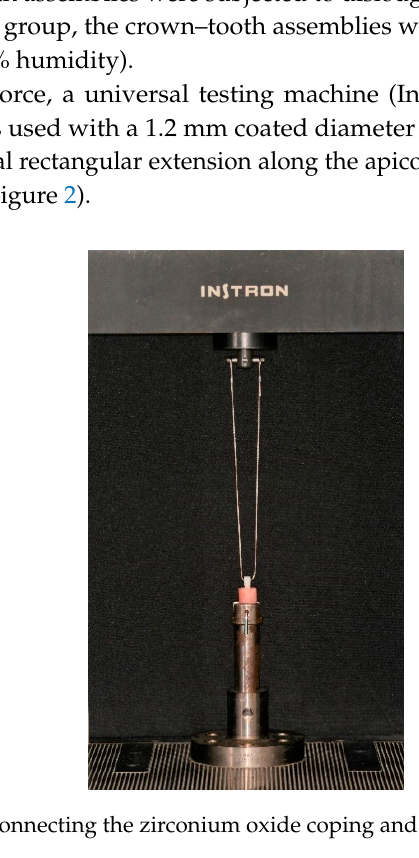
Table 1. Classification of failure criteria.